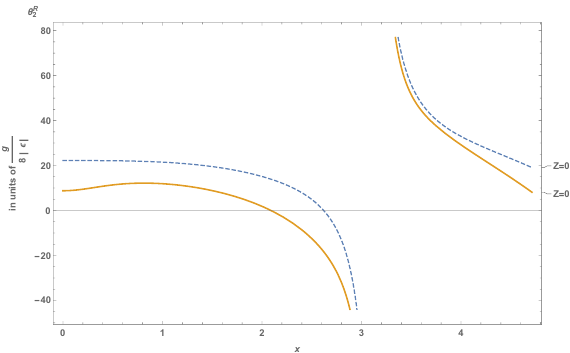
Figure 3: Kerr Rotation angle θ R 2 as a function of x = ωnL / c for Z = 0.3 and Z = 0.8 (colour